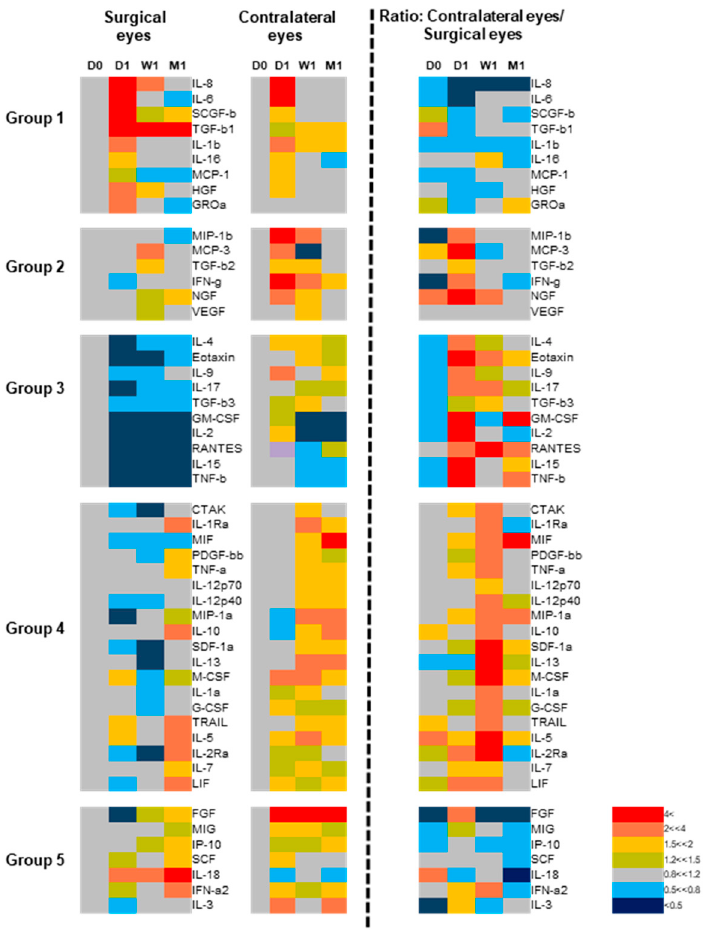
Figure 3. Five distinct kinetics of tear fluid cytokines in bilateral eyes after EK. Left and middle heat maps; surgical and contralateral eye tear protein expression kinetics at D1, W1, and M1 are shown in relative to the pre-transplant D0 baseline level. Panel on the right: The ratio of tear protein levels in the contralateral eyes against surgical eyes are shown for each time point. The grouping of the 51 proteins into five are based on the PCA analyses described in Figure 1. Transplant eyes: D0: n = 19, D1: n = 18, W1: n = 17, M1: n = 15. Contralateral eyes: D0: n = 19, D1: n = 17, W1: n = 17, M1: n = 15.